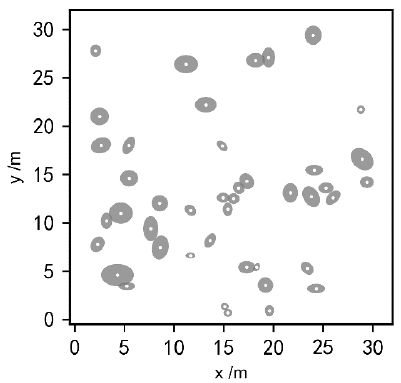
Figure 2. Distribution of shrub crowns at Site A: the gray areas represent the crowns, and the white dots represent the center of each plant.